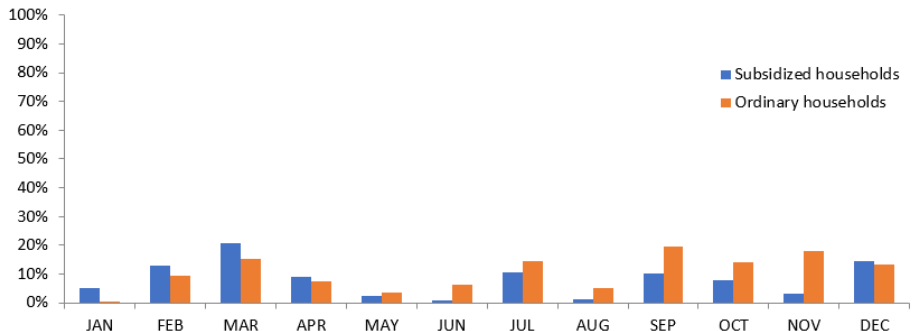
Figure 5. Oscillations in the energy consumption for ordinary and subsidised households.